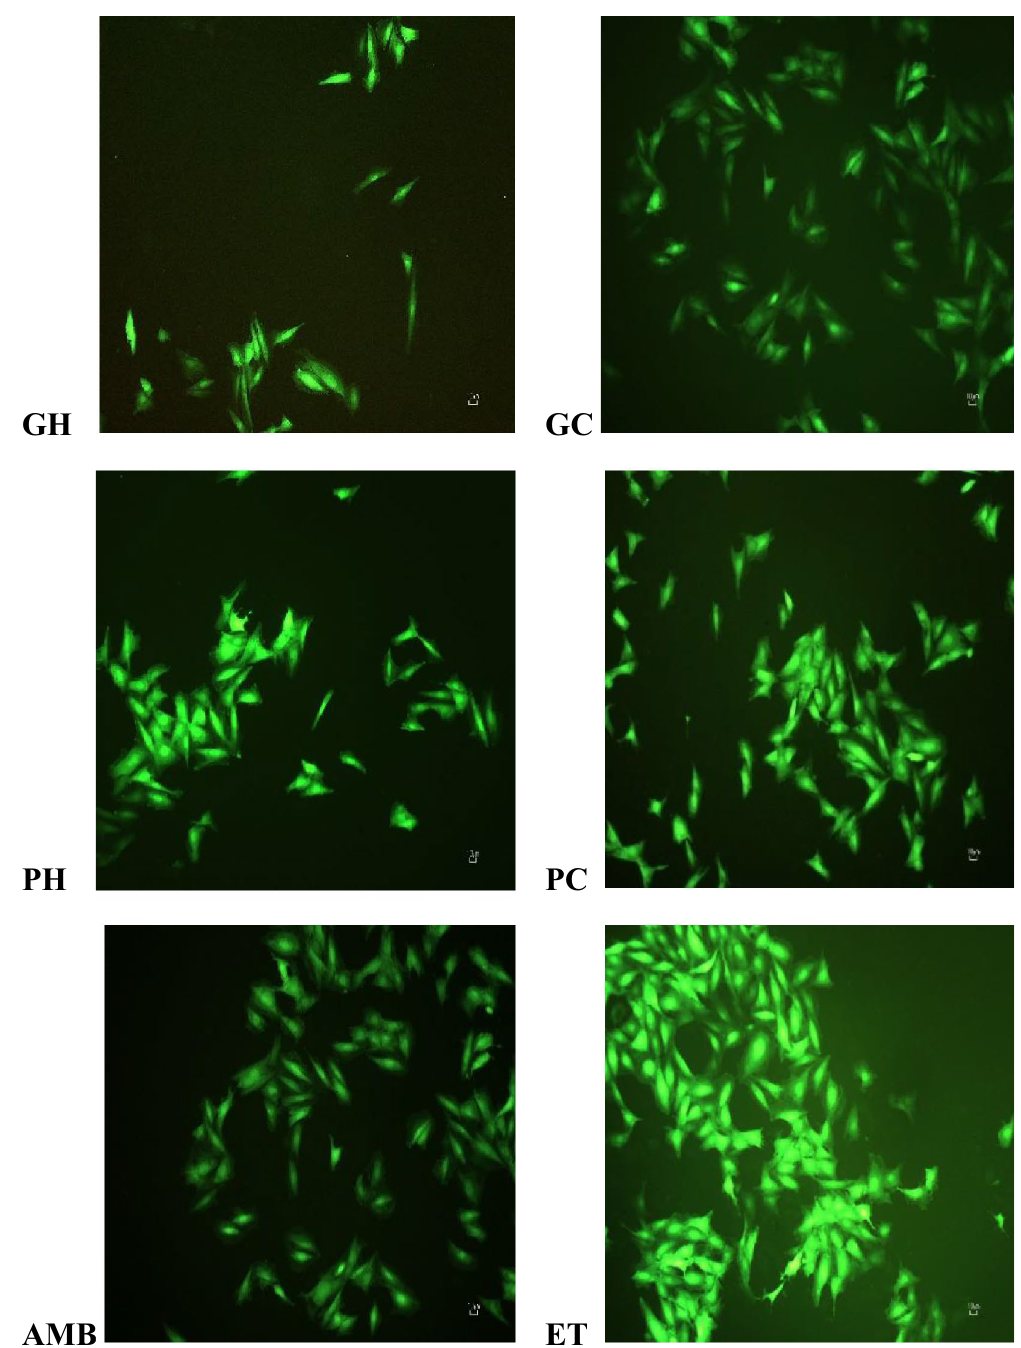
Figure 5. Fluorescence effects of the hot-water (GH) and cold-water (GC) extracts of P. cubensis and hot-water (PH) and cold-water (PC) extracts of Pan cyanescens mushrooms (50 μg/mL) and positive control (AMB) ambrisentan (25 μg/mL) on intracellular ROS production after 1-h treatment (experiments were done in three different